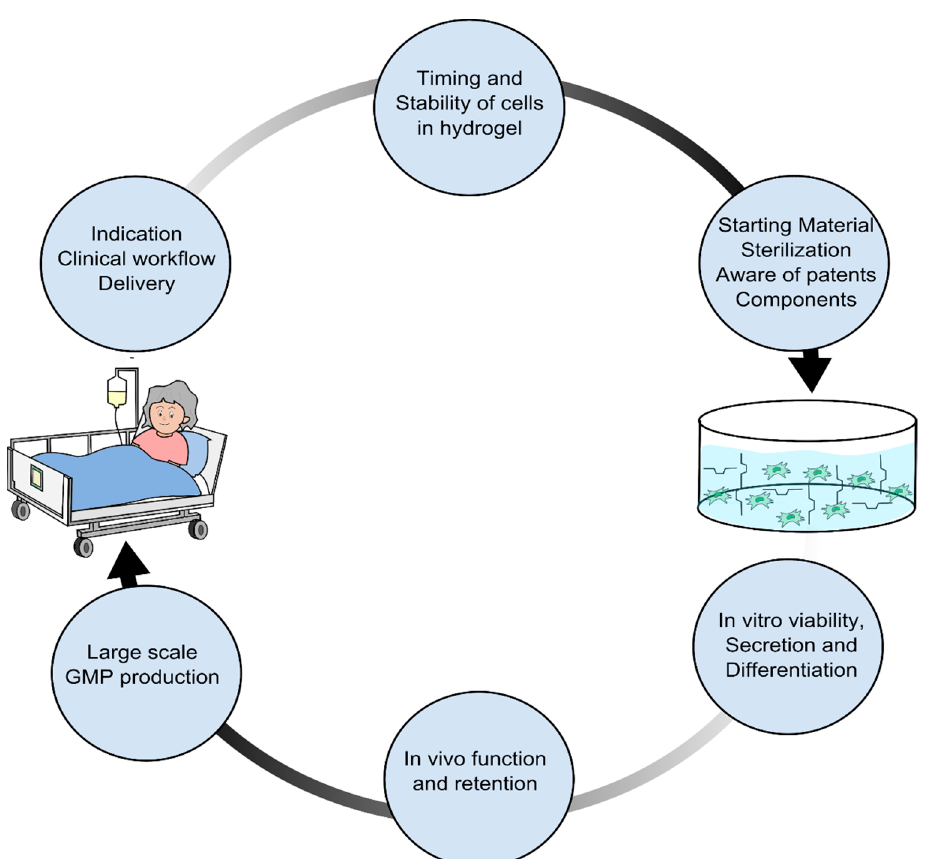
Figure 2. Hydrogel design process for accommodating potential roadblocks in clinical translation. Start with the clinical cell therapy workflow, indication, and workflow. Be aware of when in the cell production process or treatment workflow the cells are to be incorporated into the hydrogel. Be aware of stability after cross-linking for potential transportation between the manufacturing facility and the clinical department. Choose pure starting materials and components with proper documentation. The chosen gel type and components should be capable of being sterilized without losing their abilities and should not be covered by existing patents. When designs of hydrogel candidates are in place, the effect of the hydrogel on the specific cell product viability, secretion, and differentiation should be investigated, followed by in vivo investigation of potential functional benefits and retention.